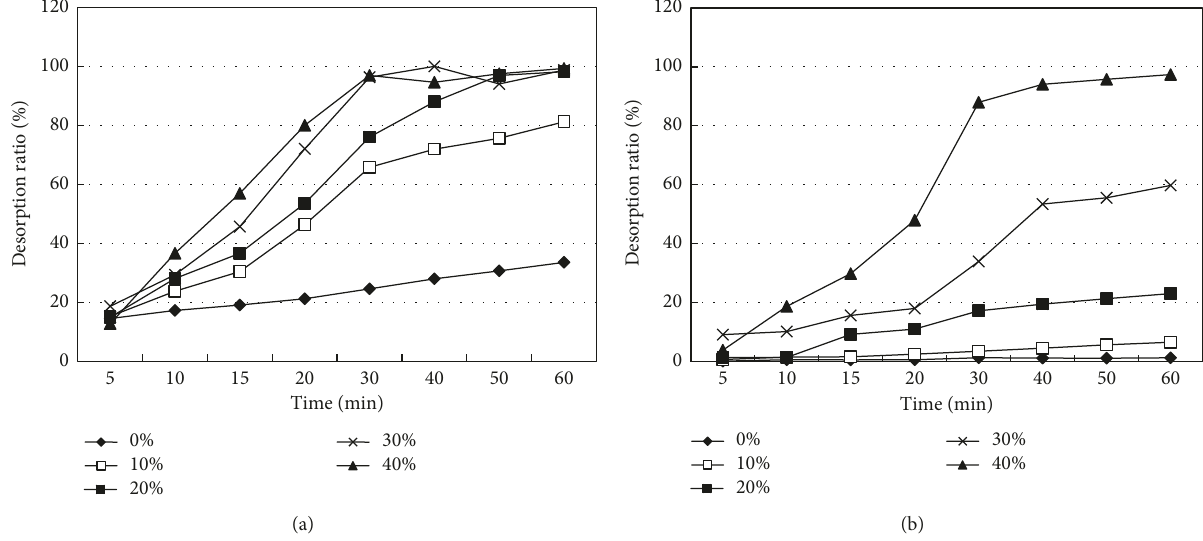
Figure 4: Desorption curves of (a) syringoside and (b) oleuropein in different ethanol concentrations on the HPD-100B